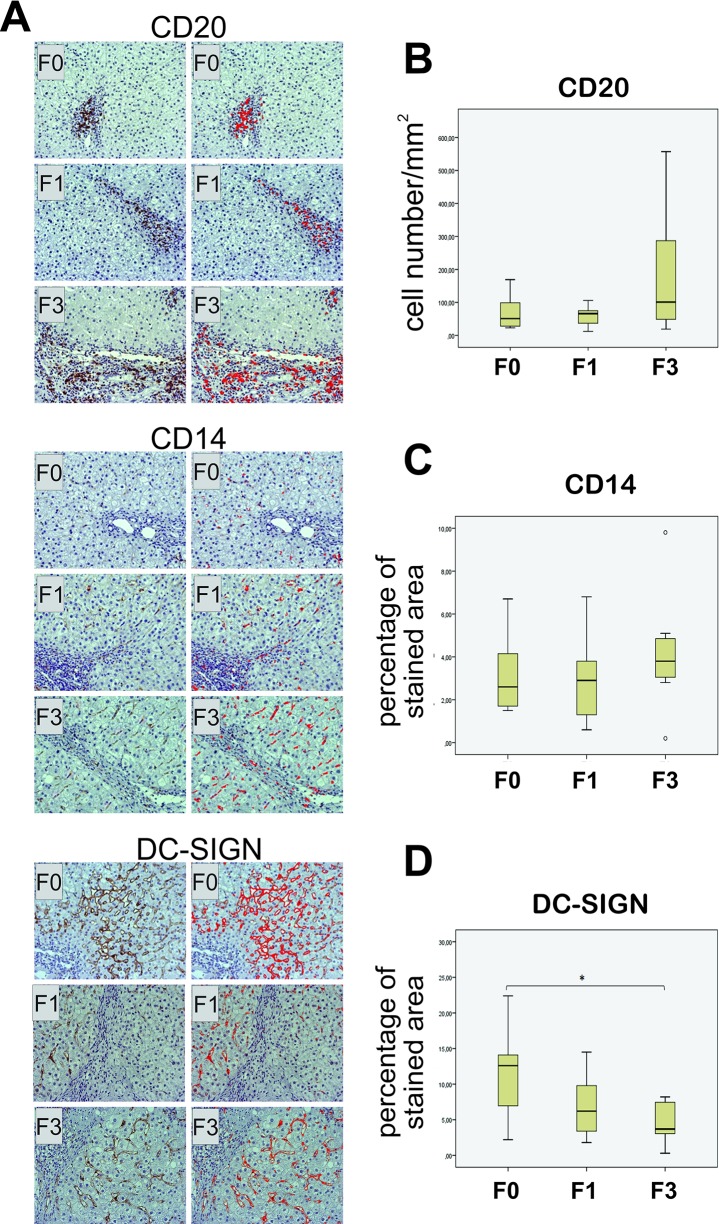
Immunohistochemical analysis of CD20+, CD14+ and DC-SIGN+ cells in liver biopsy specimens from patients in different stages of fibrosis (F0, F1, F3).(A) Liver biopsy specimens were stained for CD20, CD14 and DC-SIGN, photographed, and images (left columns) were processed using ImageJ software (right columns). The results of analysis are presented by box plots as the number of CD20+ cells per mm2 (B) or as the percent of stained area of preparation (C, D). Asterisk reflects significance of difference: *p<0.05.